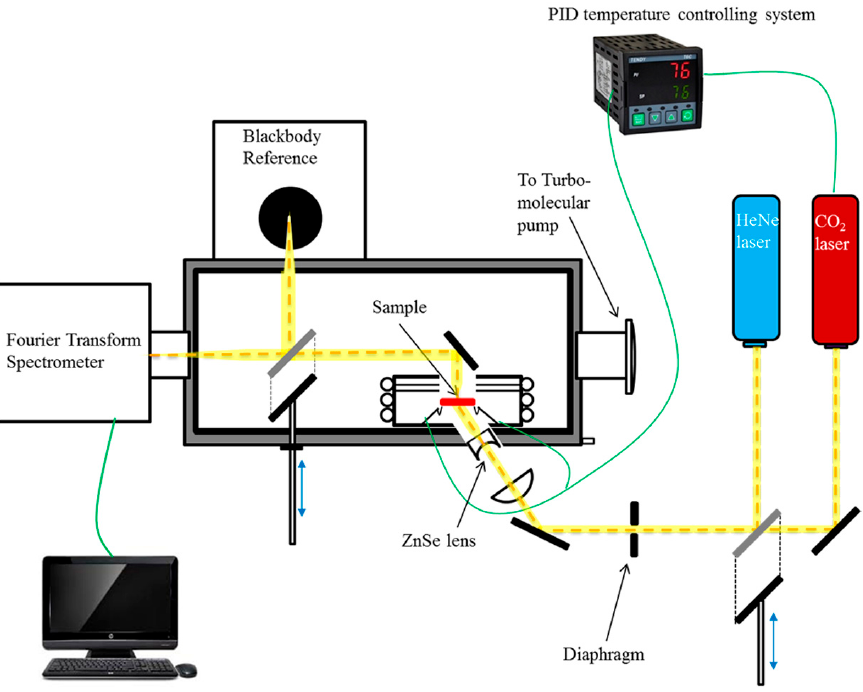
Figure 11. Schematic diagram of the emittance measurement apparatus.